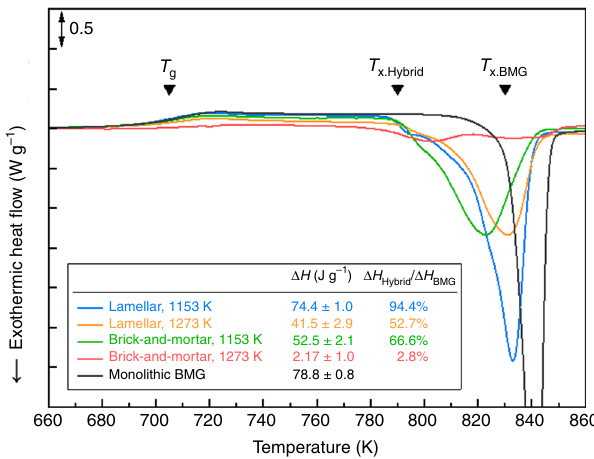
Fig. 5 Differential scanning calorimetry results for the compliant-phase ceramics. DSC traces for the alumina/BMG-forming materials with lamellar and brick-and-mortar structures in fi ltrated at 1153 and 1273 K. T g is the glass-transition temperature, T x is the onset temperature of crystallization, and Δ H is the heat of crystallization. The amorphous fraction in the metallic phase is determined by comparing the change of enthalpy during this crystallization event in the in fi ltrated ceramic – glass samples to the change of enthalpy for the monolithic BMG